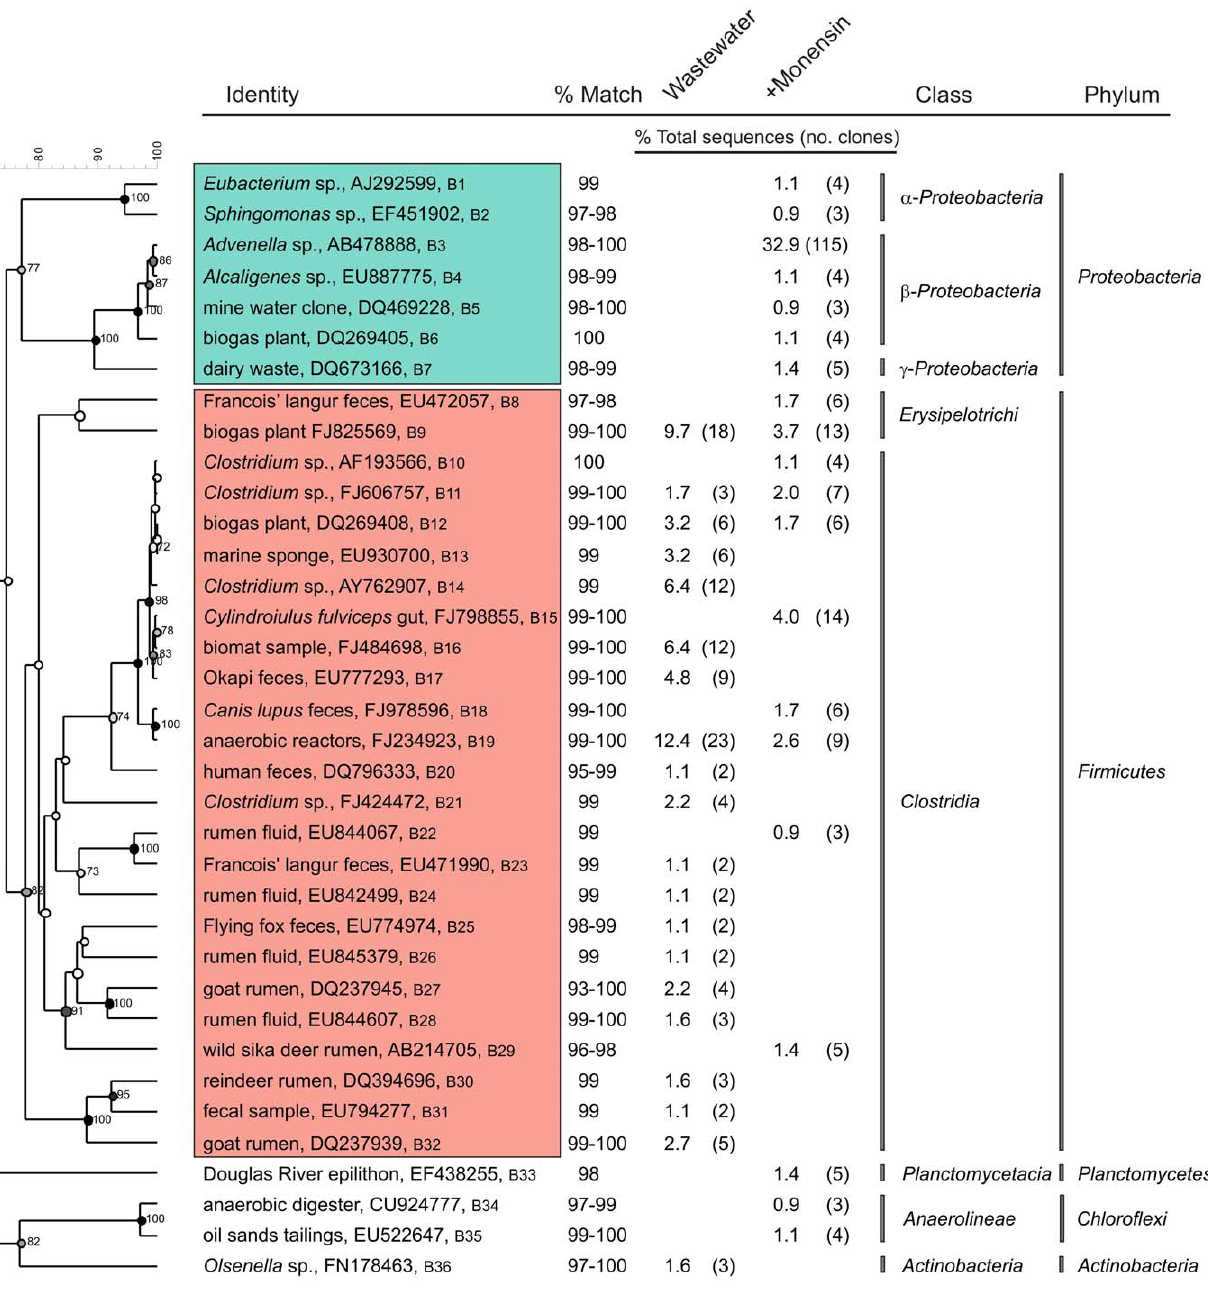
Figure 4. The 20 predominant bacterial sequences characterized from dairy wastewater treated with or without monensin. Numbers B1 to B36 in the identity column correspond to sequences submitted to GenBank under accession numbers HQ293222 to HQ293257. The numbers in parentheses following the percentage of total sequences are the number of clones that best matched with the GenBank sequences. Red and green boxes respectively denote inhibition or enrichment of bacteria by